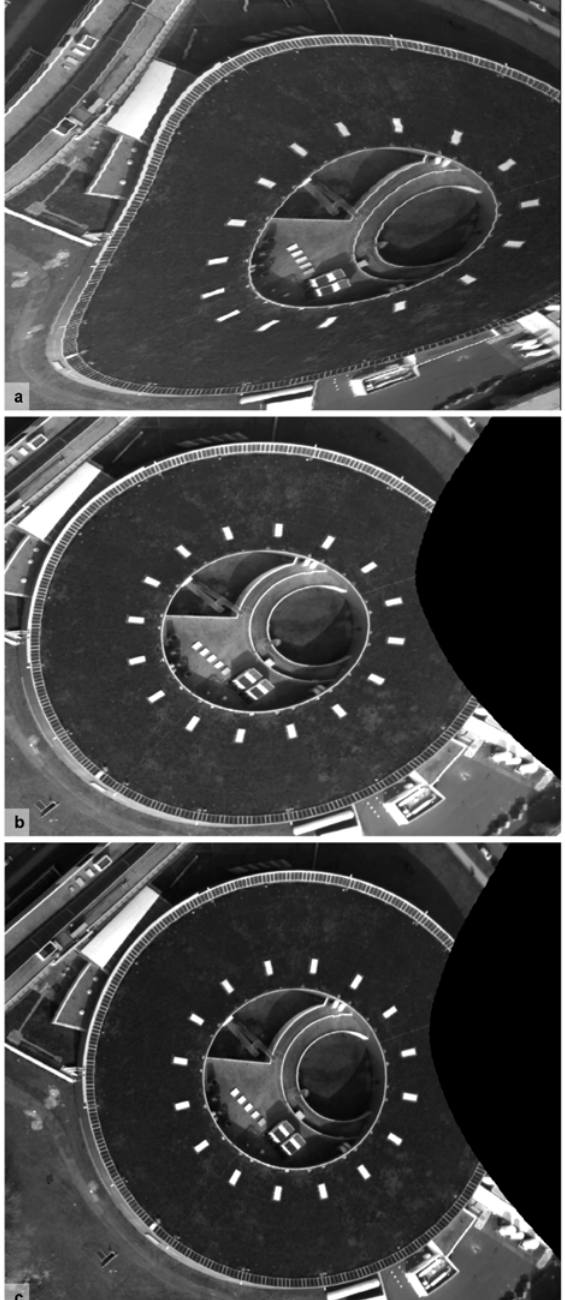
Figure 5: a: A part of the green band of an uncorrected line image (lines are just conjoined). b: The same image after pre-correction. c: The image completely corrected with the exterior orientation determined by the presented approach (the image corrected with the reference measurement is almost identical and therefore not included in this